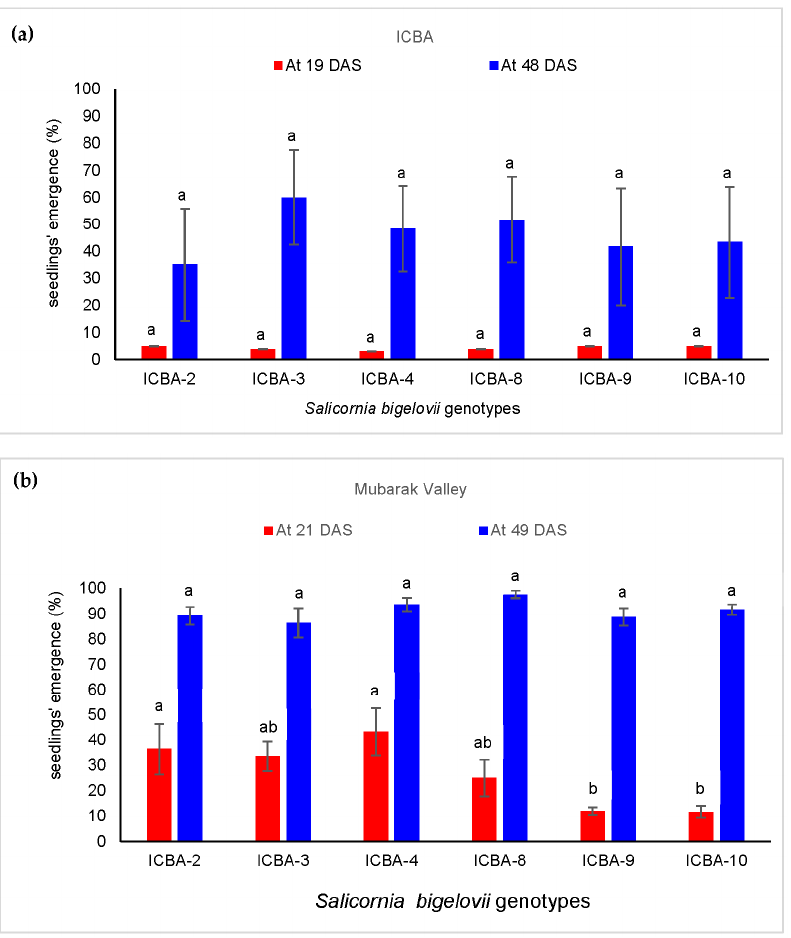
Figure 3. Seedlings’ emergence (%) of Salicornia bigelovii after ( a ) 19 and 48 days from sowing at ICBA and ( b ) 21 and 49 days from sowing at Mubarak Valley. Table 6. Growth and yield parameters (mean values ± S.E.) of six Salicornia bigelovii genotypes evaluated at ICBA and Mubarak Valley. Values having the same letter are not significantly different ( p < 0.05, p < 0.001). LSD multiple comparison test was conducted per trait per